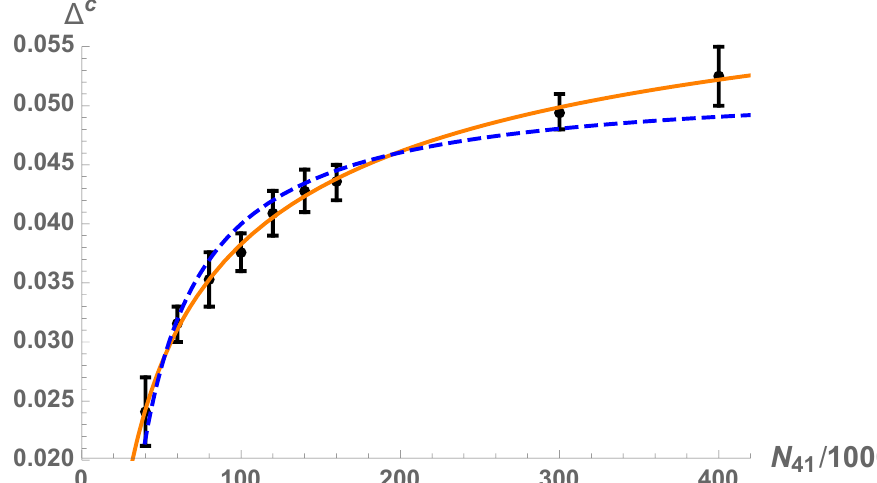
Figure 5. Lattice volume dependence of the pseudo-critical ∆ c ( N 4,1 ) values in CDT with toroidal spatial topology and for fixed K 0 = 2.2 together with the fit of the finite size scaling relation (3) with critical exponent ν = 2.7 (orange solid line) and the same fit with a forced value of ν = 1 (blue dashed